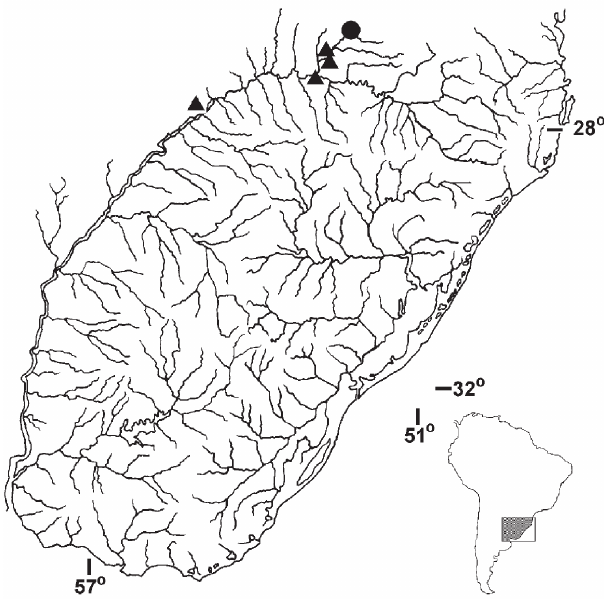
Fig. 5 . Collecting localities of Crenicichla hadrostigma (tri- angles) and Crenicichla empheres (black